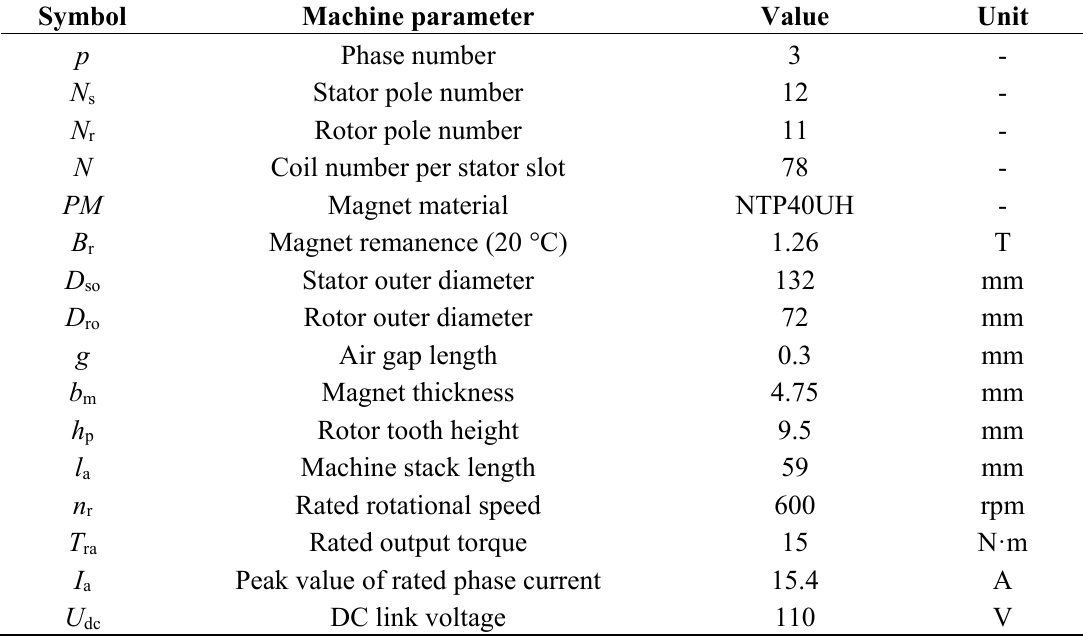
Table 1. Main design parameters of the FSPM.